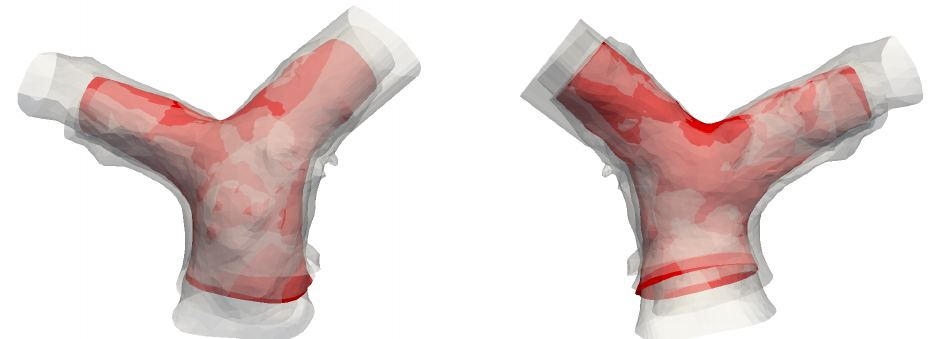
Figure 3. Front and rear view of the template (in red), superimposed with the five original